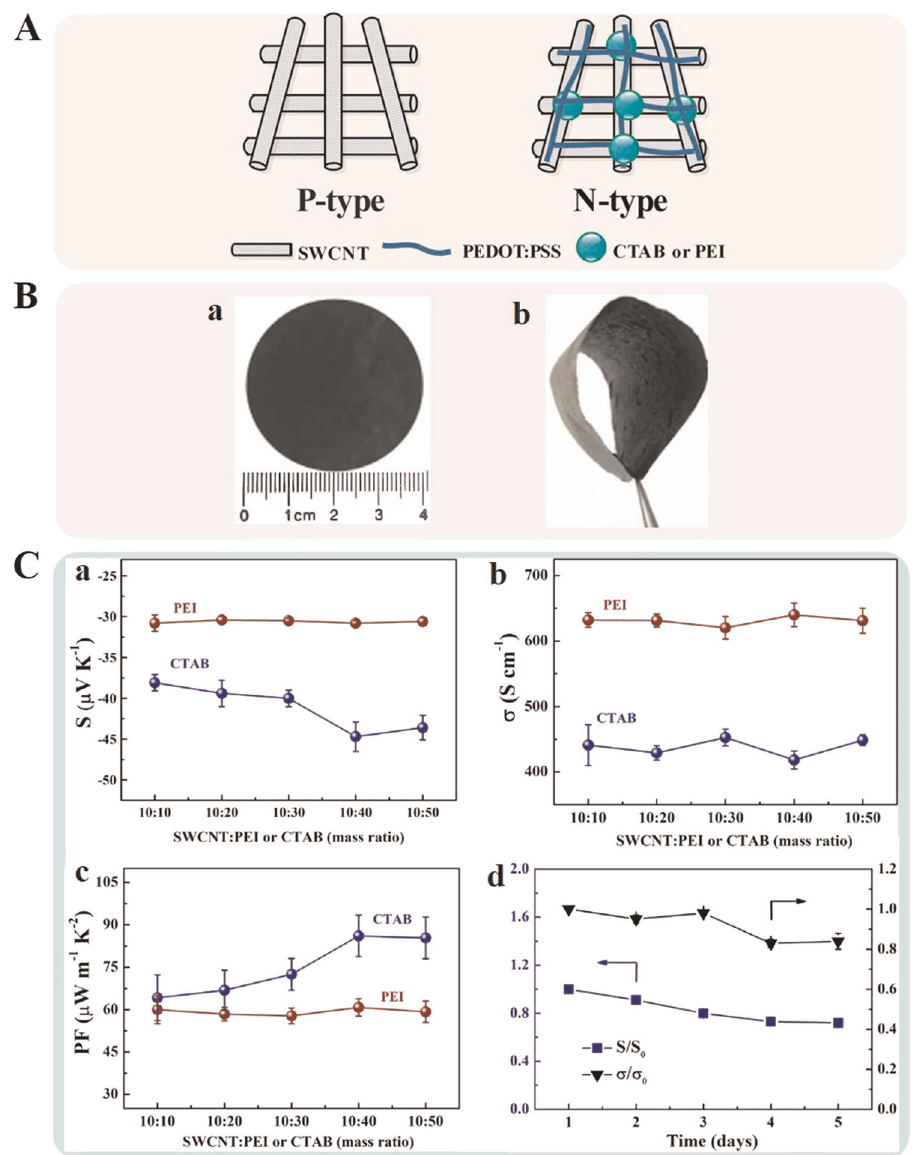
Fig. 1 P- and n-type materials. a Schematic illustration of the p- and n-type materials. b Photographs of a the composite fi lm and b its high fl exibility. c TE performances of the n-type composites including SWCNT/PH1000/PEI and SWCNT/PH1000/CTAB: a Seebeck coef fi cient, b electric conductivity, and c power factor, where the PH1000 content keeps constant. d The stability test of the SWCNT/PH1000/CTAB composites in air without